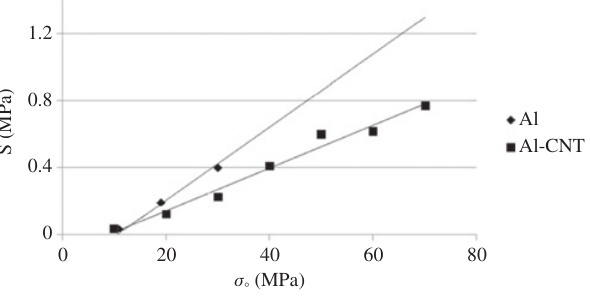
Figure 6: Rate of stress relaxation ( S ) as a function of initial tensile stress ( σ ) for aluminum and Al-CNT o